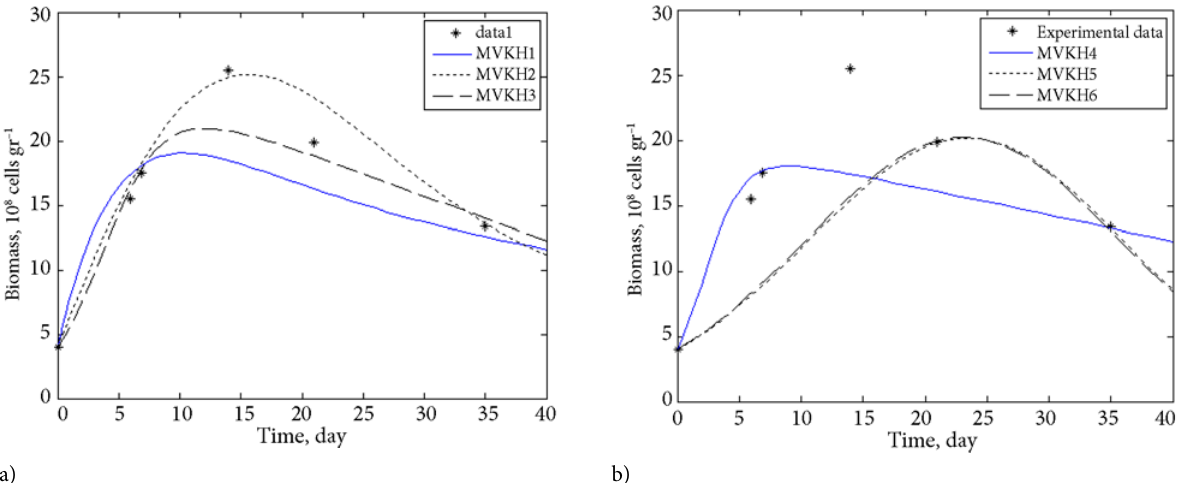
Fig. 1. a) – predictions of the biomass variations versus time using MVKH1 to MVKH3 growth kinetic models accompanied with Beolchini et al. (2010) experimental data for growth of prokaryotic communities on aliphatic and polycyclic aromatic hydrocarbon contaminants in the first case of simulation; b) – predictions of the biomass variations versus time using MVKH4 to MVKH6 growth kinetic models accompanied with Beolchini et al. (2010) experimental data for growth of prokaryotic communities on aliphatic and polycyclic aromatic hydrocarbon contaminants in the first case of